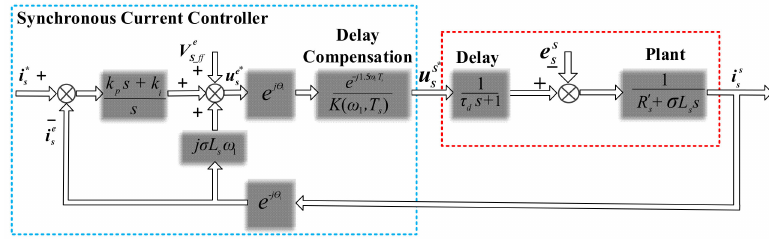
Figure 15. PI-based current decoupling controller with delay